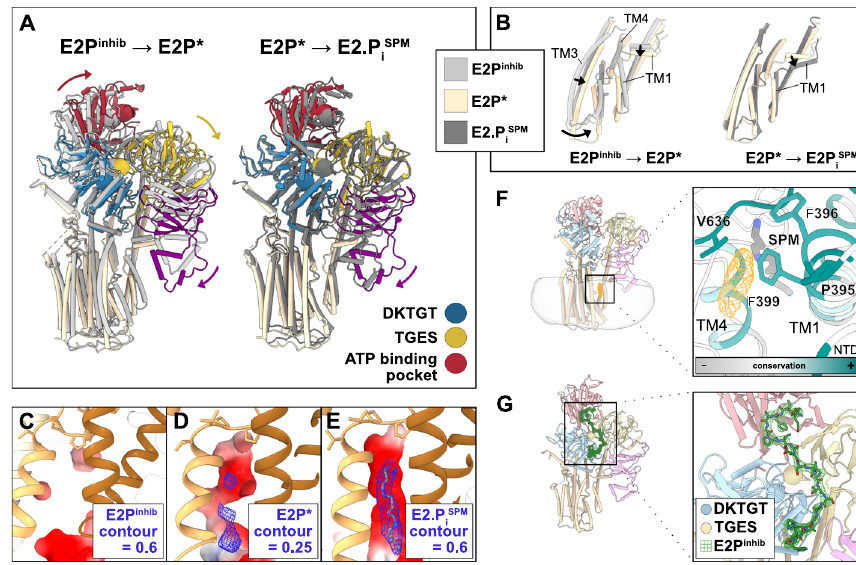
Fig. 3 Conformational changes during polyamine uptake, lipid regulation, and auto-inhibition. a Alignment of the generated structures on the P domain. Conserved motifs in the soluble domains are shown as spheres. b Alignment on TM5 – 10, and close-view of conformational changes in TM1 – 6. c – e Close- view of the polyamine binding pocket in the E2P inhib ( c ), E2P* ( d ), and E2.P i ( e ) states. EM density around SPM is shown in the blue mesh. f Side-view and a close-up of the lipid density in a conserved cleft formed by TM1, 3, and 4, illustrating the position of the lipid at the cytosolic membrane lea fl et. The close- view shows conserved side chains in proximity to the lipid density, colored by conservation, as determined by AL2CO implemented in ChimeraX 42,45 , excluding side chains with poor conservation (<1). g Side- and close-views showing the location of the auto-inhibitory N-terminal residues (mesh, dark green) in the E2P inhib state. The DKTGT and TGES motifs of the P- and A-domains are shown as spheres. The autoinhibitory residues are interacting with the TGES loop and the nucleotide-binding pocket of the N